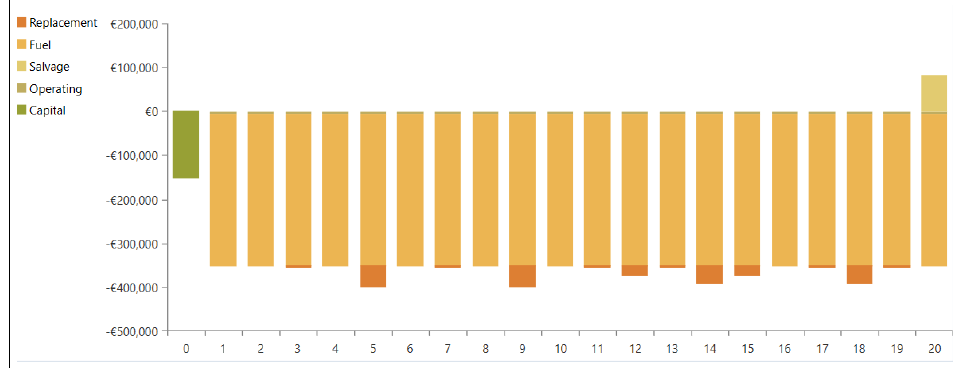
Figure 11. Cash flow by Cost type Scenario 1.